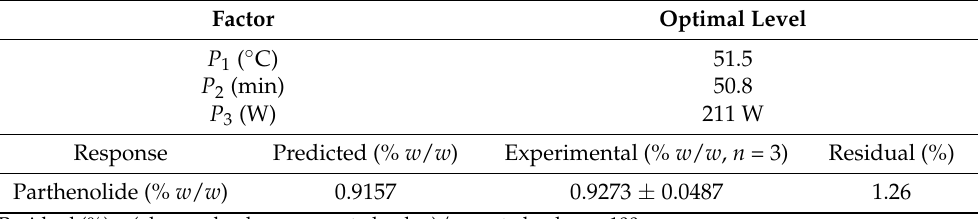
Figure 5. Linear correlation plot between actual and predicted values for R. Table 6. Observed and predicted levels for optimal extraction conditions.